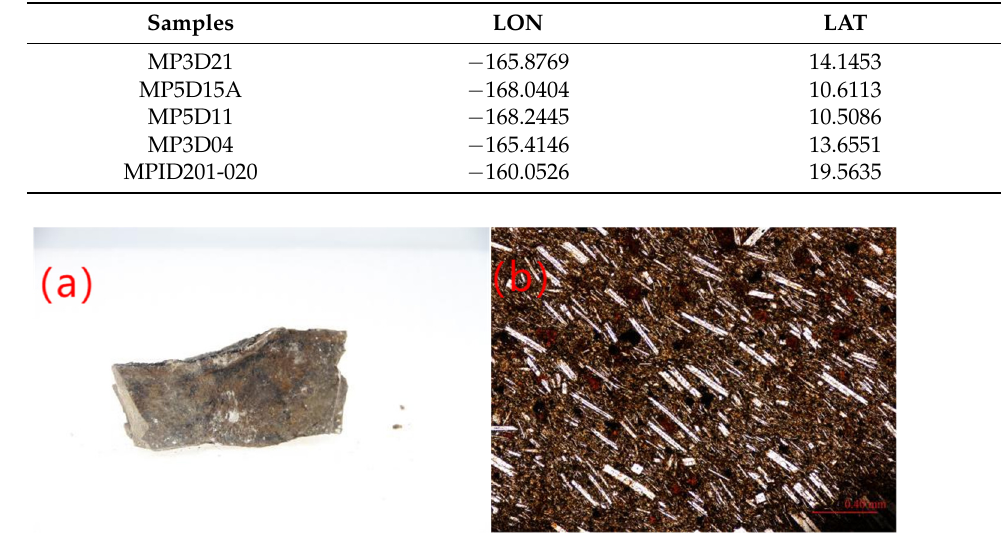
Figure 2. Tapical photographs of basalt hand specimen ( a ) and orthogonal–polarized light photomicrograph ( b ) of sample from Western Pacific seamounts.